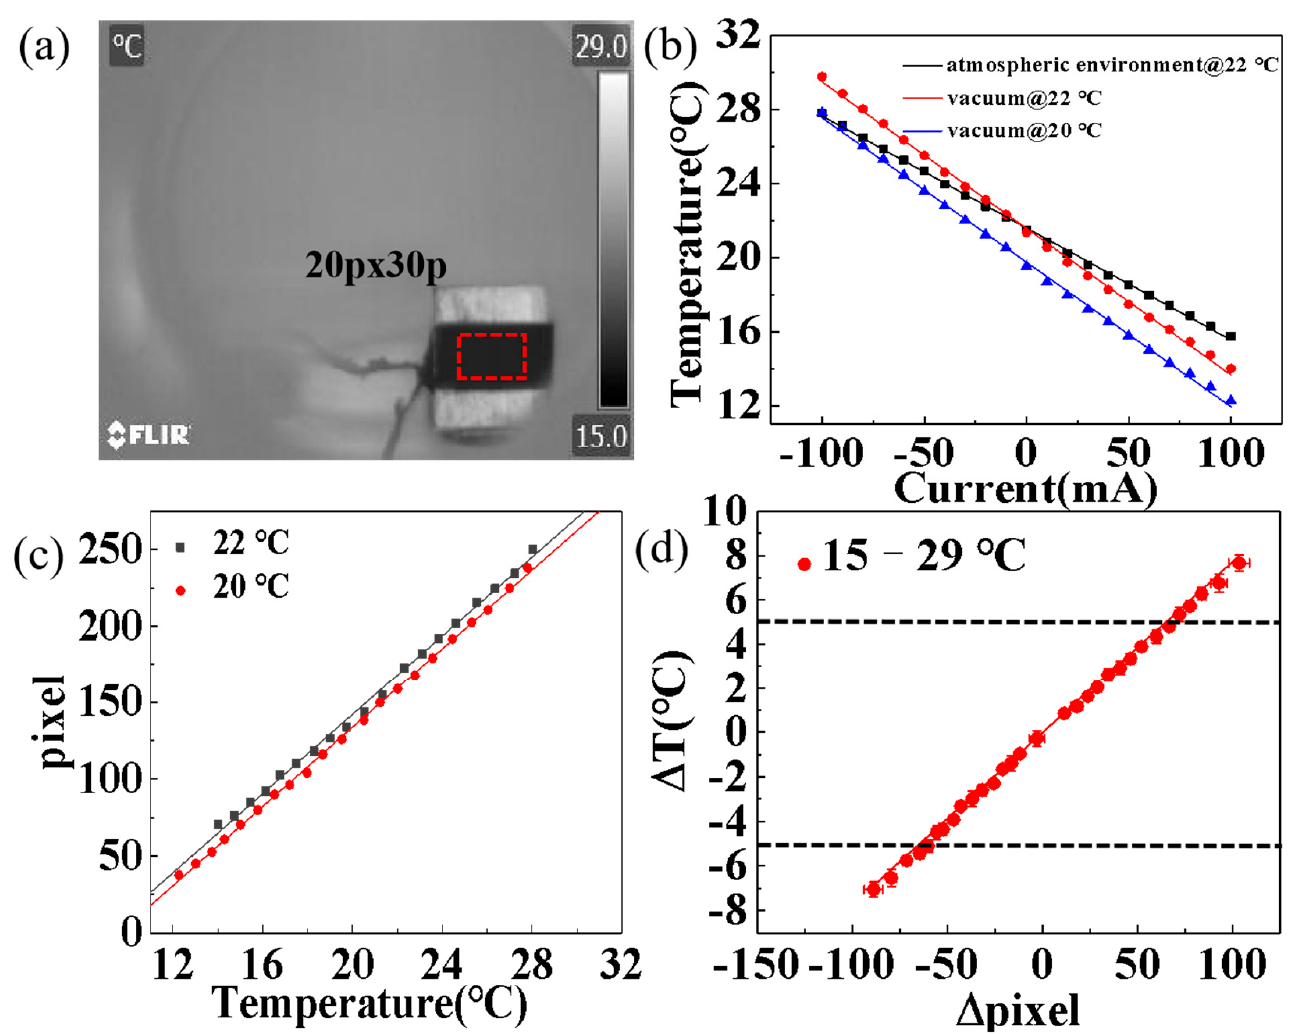
Figure 3. The calibration of the thermal camera. ( a ) The side view of the thermal image of the CGTC through the BaF 2 windows. The red dash area on the surface of the sample is used for calculating the average pixel intensity. ( b ) The variation in the reference crystal temperature with TEC current for three cases. ( c ) Calibrating the relationship between the pixel values of the sample thermal image and its temperature. ( d ) The relationship between the pixel value changes of the sample thermal image and its temperature.